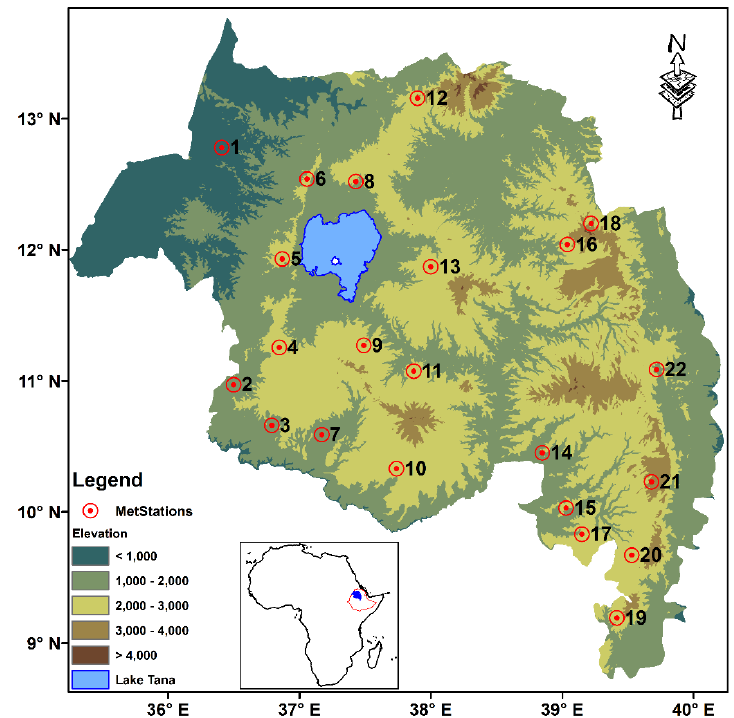
Figure 1. Location map of the study area with meteorological stations superimposed over an elevation map of the Amhara Region, Ethiopia. Names and descriptions for these stations are given in Table 1. Table 1. List of meteorological stations mapped in Figure 1 with their geographic locations and elevation. Stations are sorted by longitude. Note that the station number (SN) in this table corresponds to station labels in Figure 1.